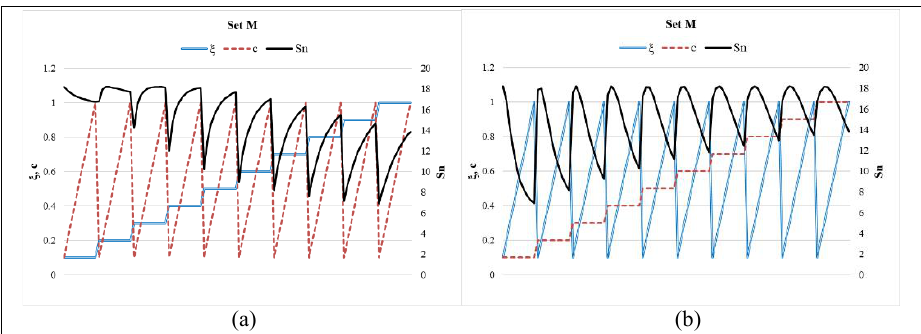
Fig. 3. The wealth 𝑆 2500 obtained by running the universal portfolio (13) on the data set M for 0.1 ≤ 𝜉 ≤ 1 and 0.1 ≤ 𝑐 ≤ 1 . The series 𝜉 and 𝑐 are plotted on the primary axis while series 𝑆 𝑛 is plotted on the secondary axis.